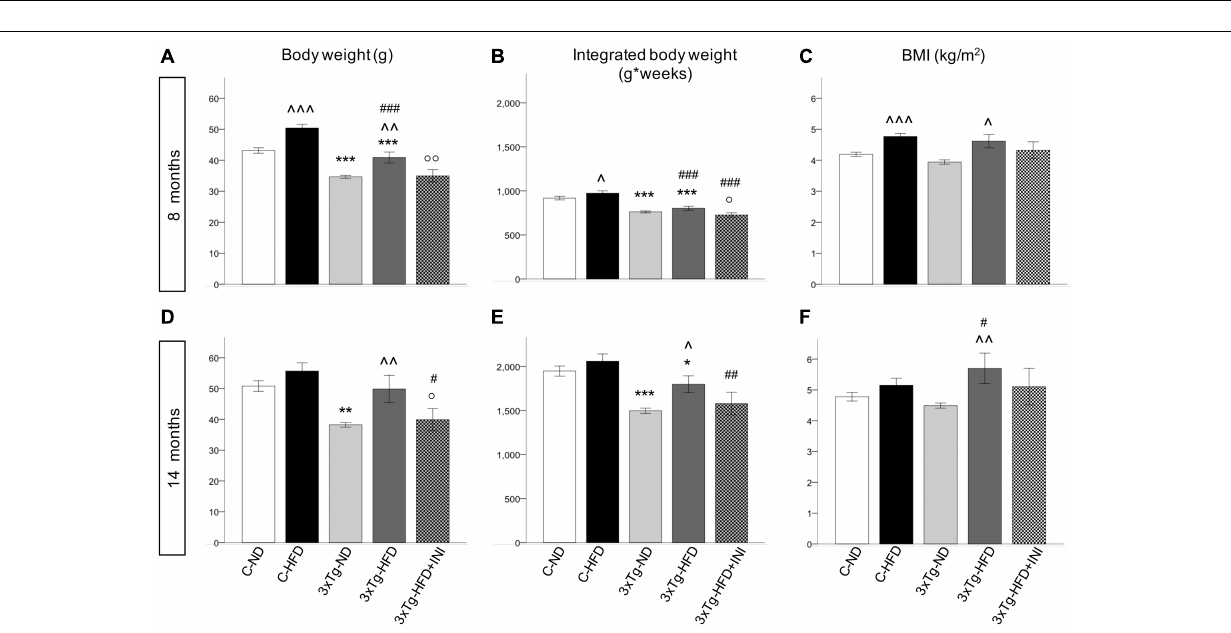
defective. Chronic INI resulted in normal dimensions of dentate gyrus area, suprapyramidal, and infrapyramidal layer thickness, which were significantly larger in 3 × Tg-HFD-INI than in 3 × Tg- HFD mice, and comparable to C-ND